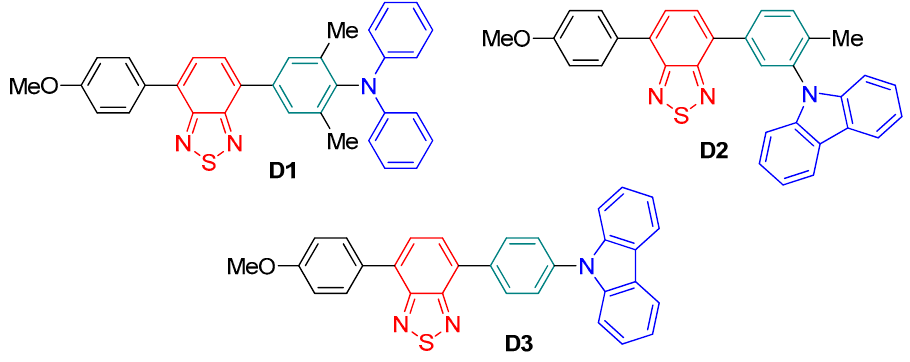
Figure 1. Structures of the BTD Dyes D1 , D2 , D3 .